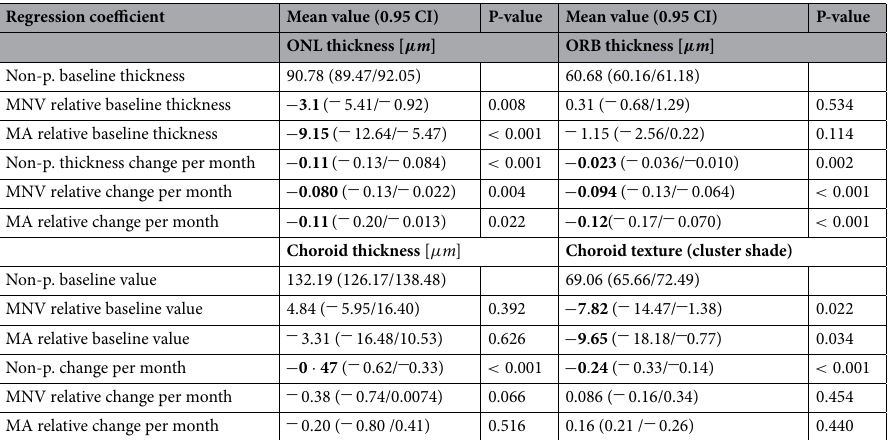
Table 2. Regression coefficients of longitudinal joint models. Regression coefficients for ONL, ORB and choroidal thickness, as well as choroidal texture showing the baseline thickness or texture value and change over time per month for the three groups. Non-progressors were used as reference and values for progressors are relative to non-progressor values. P-values report the statistical significant difference of the value to 0. Bold values indicate statistical significance ( P < 0.05 ). Non-progressor (Non-p.), Macular neovascularization (MNV), macular atrophy (MA), confidence interval (CI) .